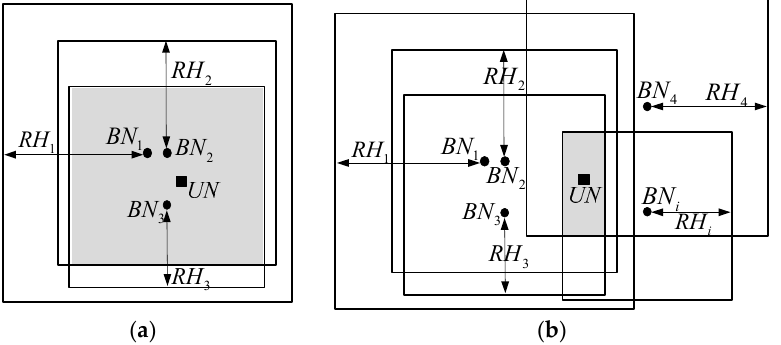
Figure 6. Population constraint strategy. ( a ) Population constraint based on three beacon nodes; ( b ) Population constraint based on all beacon nodes.